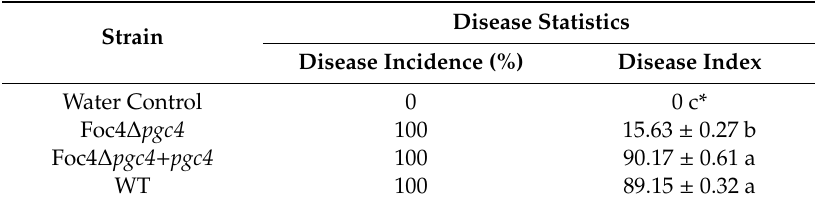
Table 2. Virulence assay of wild-type (WT), mutant Foc4 Δ pgc4 , and complemented strain